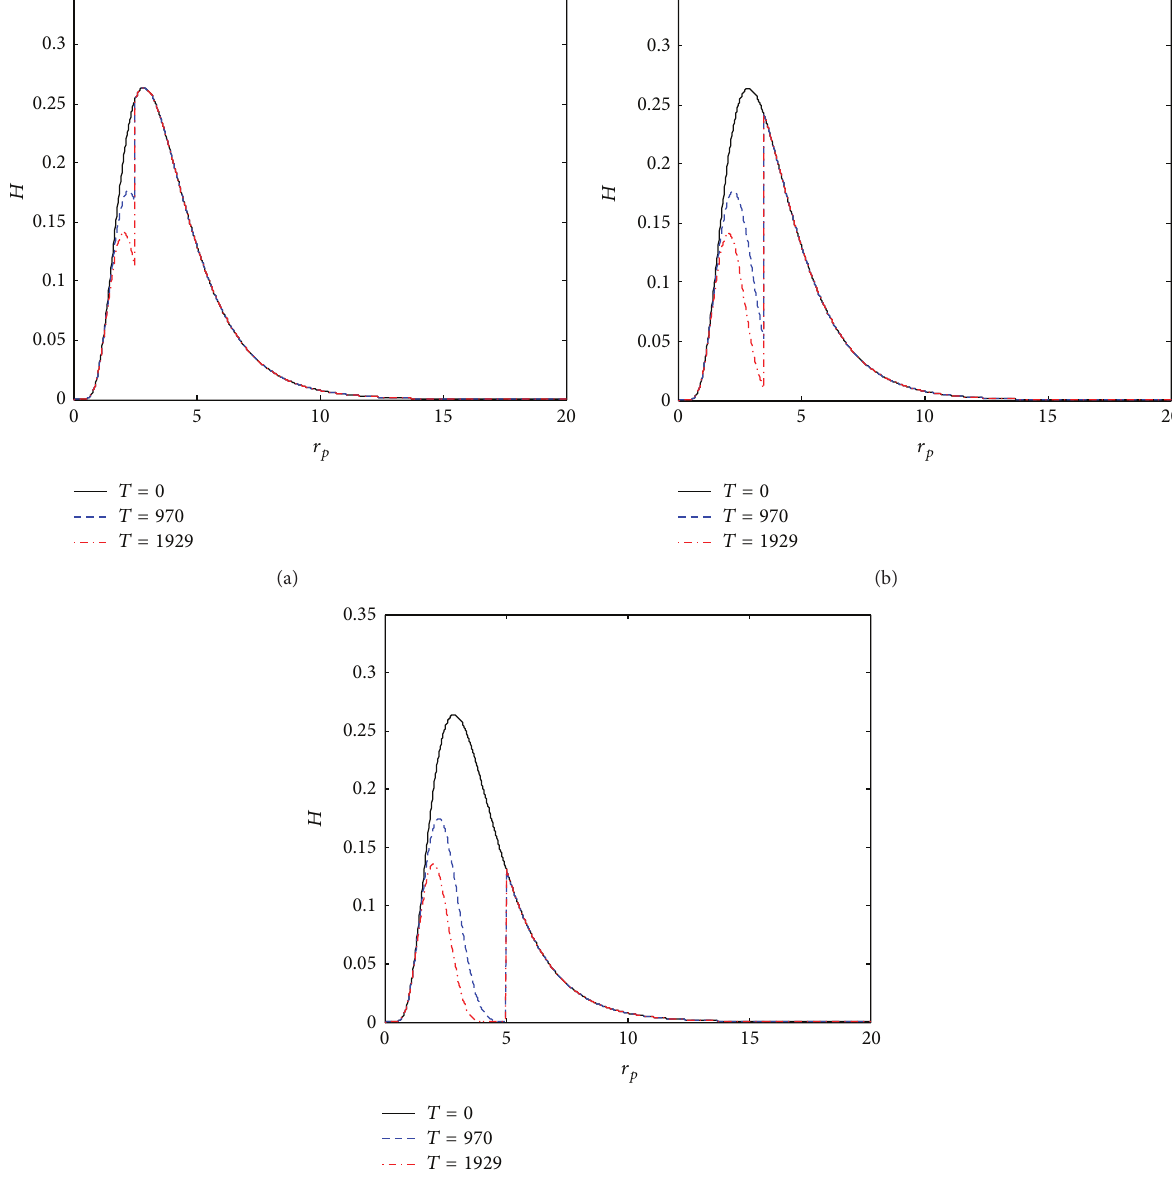
The geometrical model of parallel capillaries